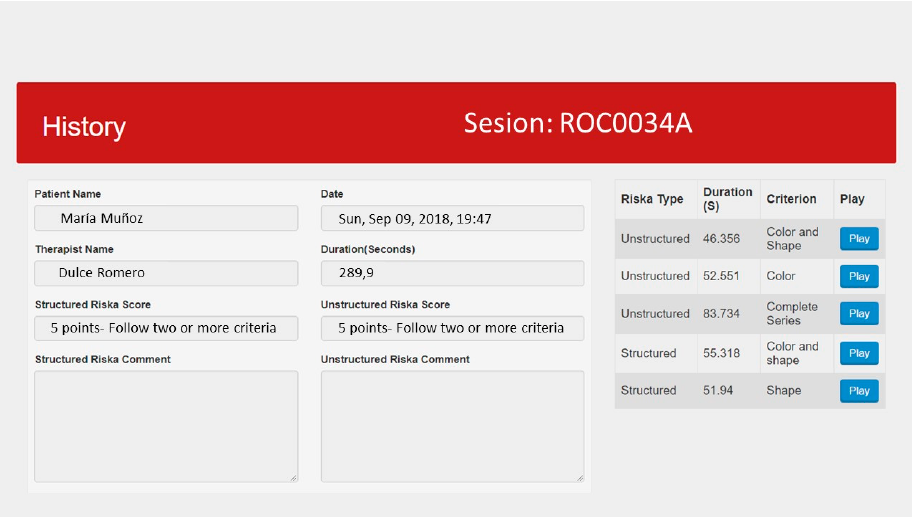
Figure 3. Assessment session review user interface.